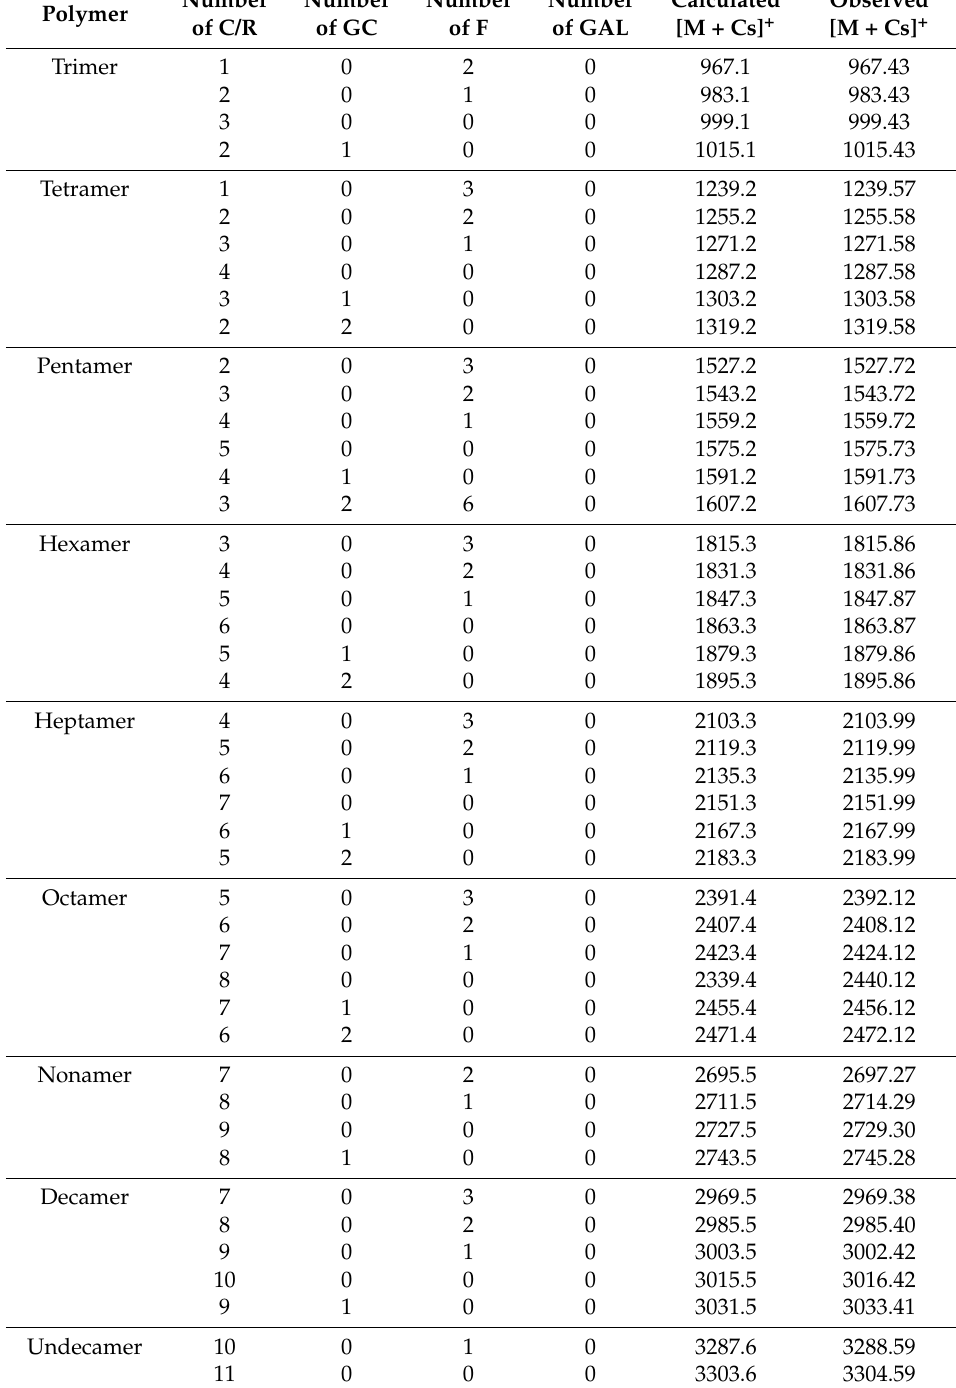
Table 2. PAs detected by matrix-assisted laser desorption/ionization-time-of-flight mass spectrometry from